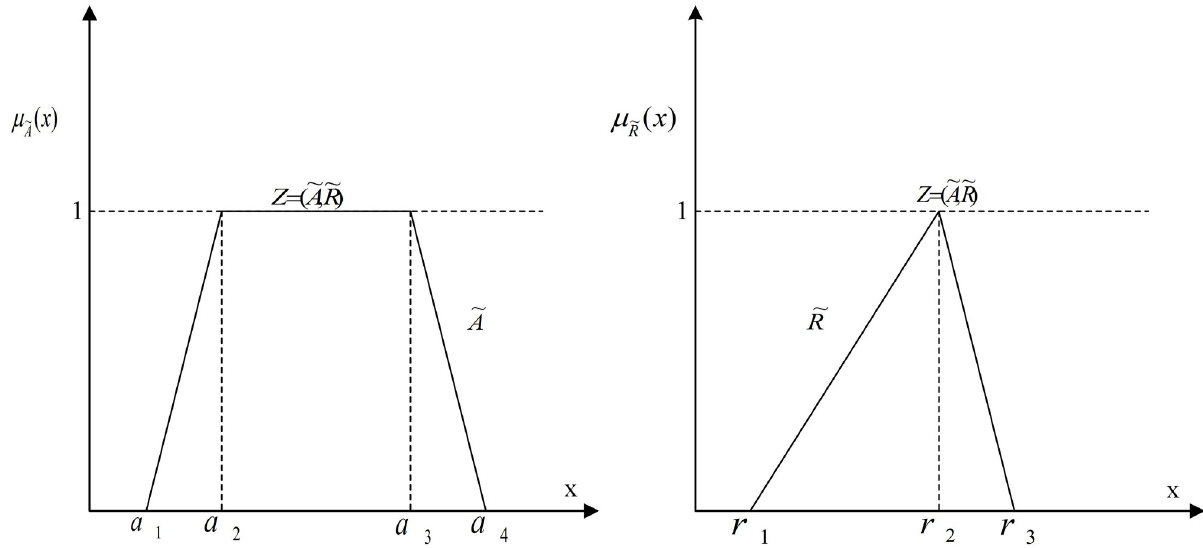
Fig 2. A simple Z-number, Z ¼ ð A ~ ; R ~ Þ . A ~ is a fuzzy restriction and R ~ is the reliability of A ~ value.